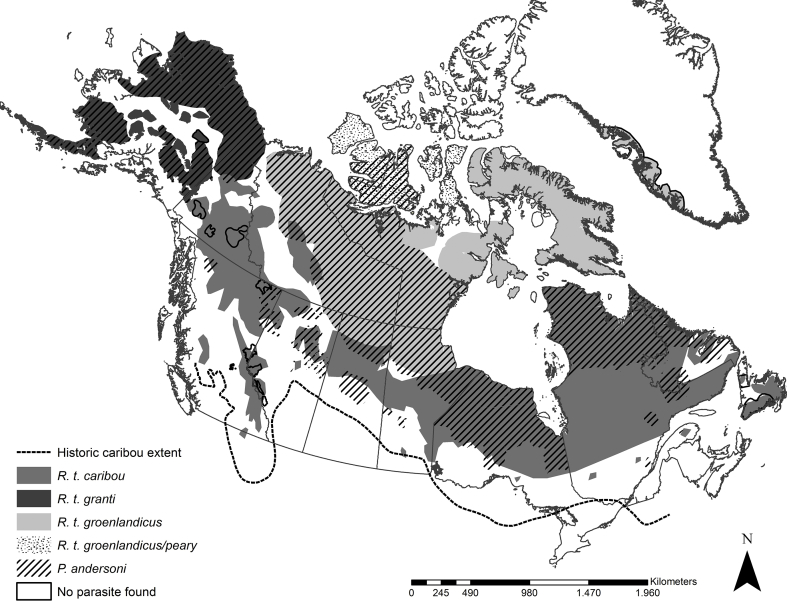
Map of Northern North America, including Alaska, USA, Canada and Greenland depicting the geographic distribution of caribou subspecies (Rangifer tarandus sspp.). The distribution of the muscleworm, Parelaphostrongylus andersoni in caribou is shown based on compiled data from the present study, and all reports in the literature (Lankester and Hauta, 1989; Lankester and Fong, 1998; Kutz et al., 2007, 2012; Kafle et al., 2017a, Kafle et al., 2017; Turgeon et al., 2018). The historic southern range of distribution of caribou is shown as a dotted line to assist in the discussions on the historical biogeography of protostrongylid lungworms and Rangifer.